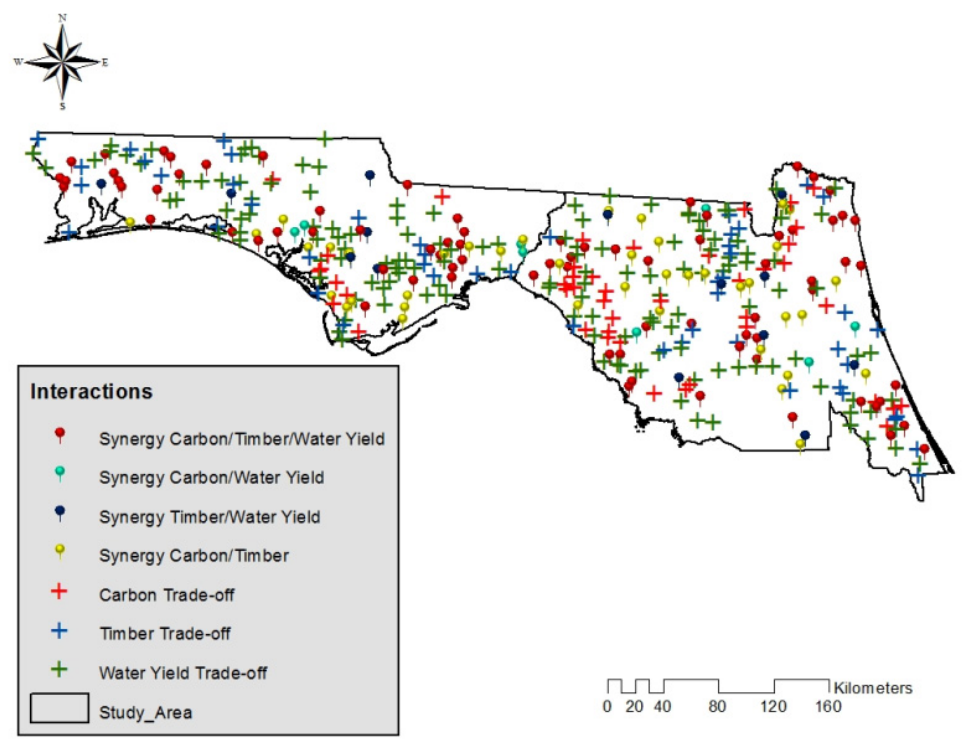
Figure 7. Ecosystem services interactions among net carbon sequestration, timber volume and water yield for Forest Inventory Analysis (FIA) Pinus elliotti plots in Florida’s northeastern and northwestern survey units,